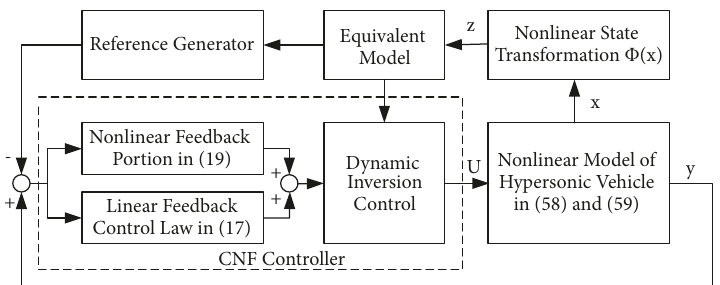
Figure 2: Structure diagram of guidance and control design using CNF technique for hypersonic vehicle.